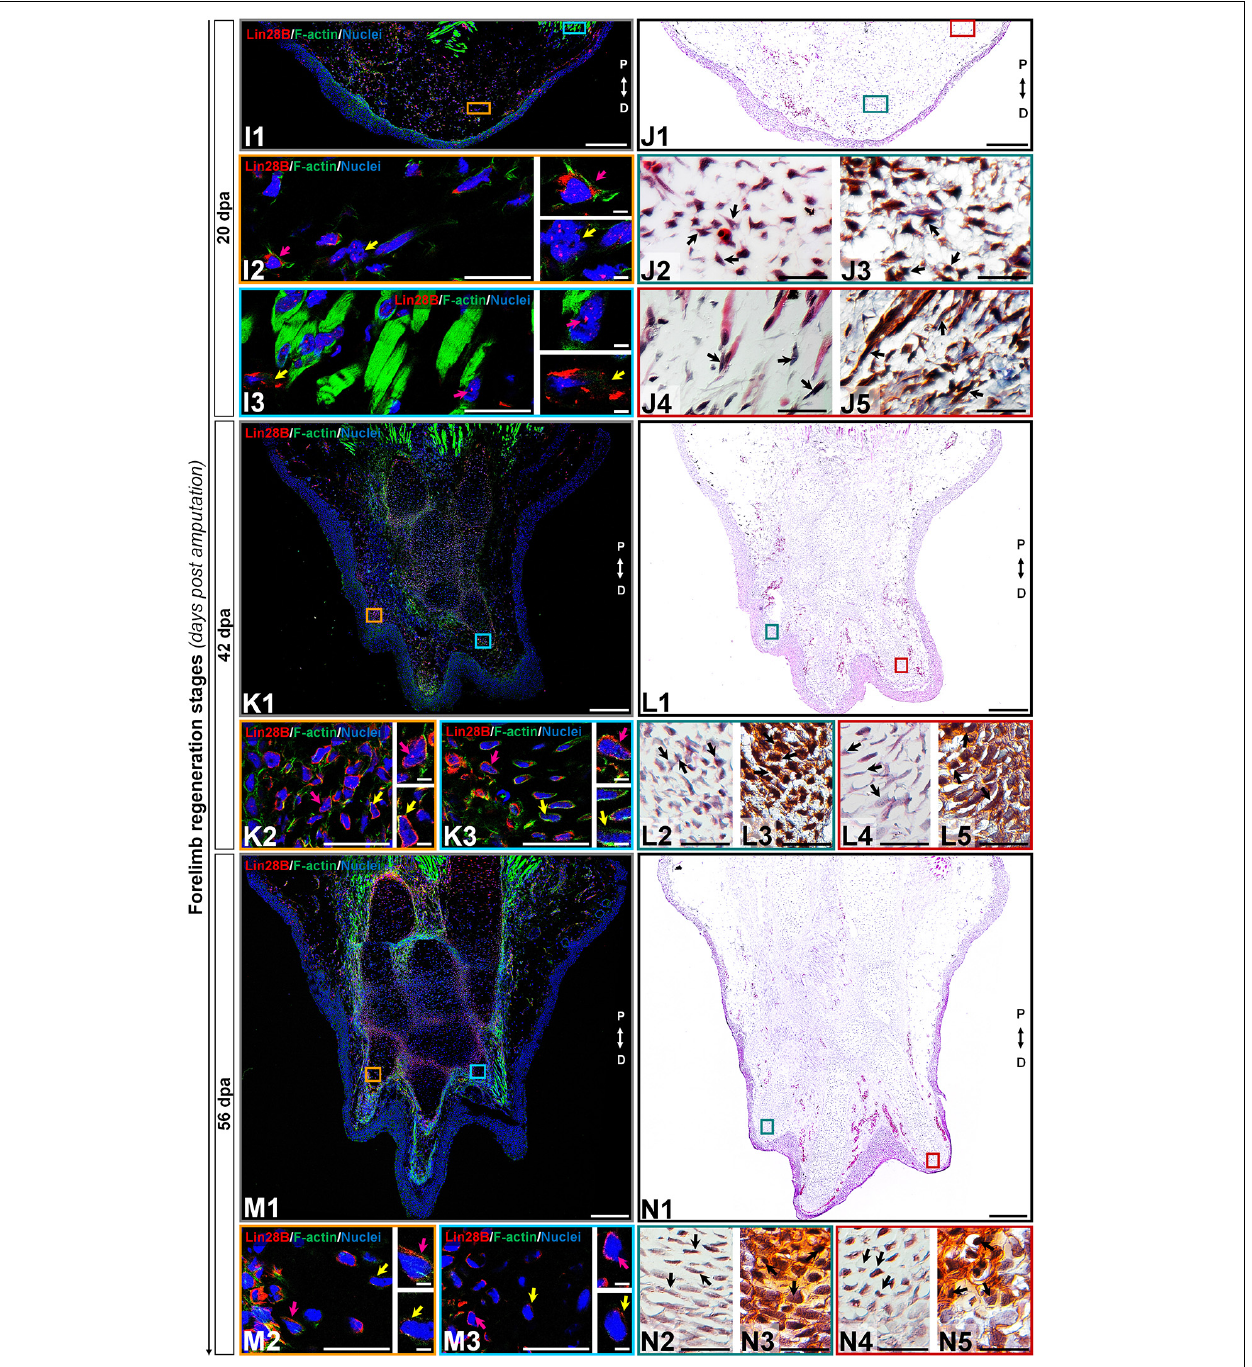
FIGURE 4 | Subcellular immunolocalization of amxLin28B during forelimb regeneration (continuation). (I–N) Histological sections of representative stages during the limb regeneration oriented in the Proximal-Distal axis. (I,J) Medium blastema stage (20 dpa). (K,L) Late palette–early digits stage (42 dpa). (M,N) Late digits–growth stage (56 dpa). (I1,K1,M1) Intracellular localization dynamics of amxLin28B marked in red, by contrast with DAPI (blue) and Phalloidin (green) that delimit nuclei and cell shapes, respectively. Scale bars: 500 µ m. (I2-3,K2-3,M2-3) Magnifications with different color contours to remark some areas of interest for amxLin28B in red, DAPI in blue, and Phalloidin in green; arrows in yellow and magenta have in turn their own zoom in. Scale bars: 50 and 5 µ m, respectively. (J1,L1,N1) The architectural organization of tissues is shown with Hematoxylin and Eosin staining. Scale bars: 500 µ m. (J2/4,L2/4,N2/4) Magnifications with distinct color contours to indicate some areas of interest in Hematoxylin and Eosin staining. Scale bars: 50 µ m. (J3/5,L3/5,N3/5) Histological changes detected on extracellular matrix for similar zones indicated in H&E ampliations, which are displayed with a differential staining to connective tissue. Scale bars: 50 µ m. The different arrows indicate diverse tissue components, as described in